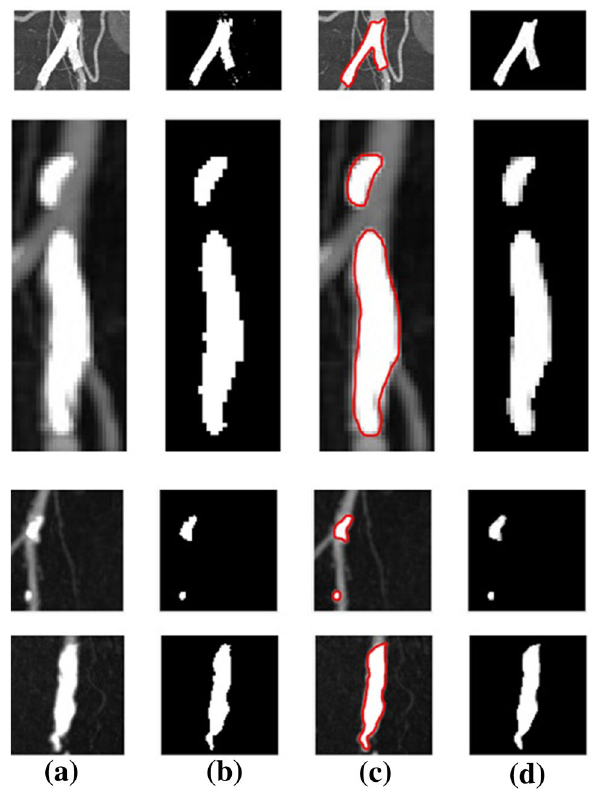
Fig. 9 Definition of verification procedure: a selected RoI, b multilevel image segmentation, c manual outline, and d manual segmentation